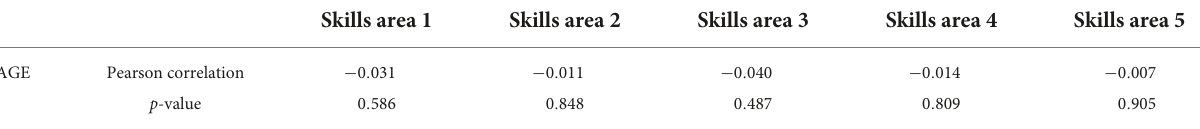
TABLE 7 Analysis of the correlation between age and level of digital skills.